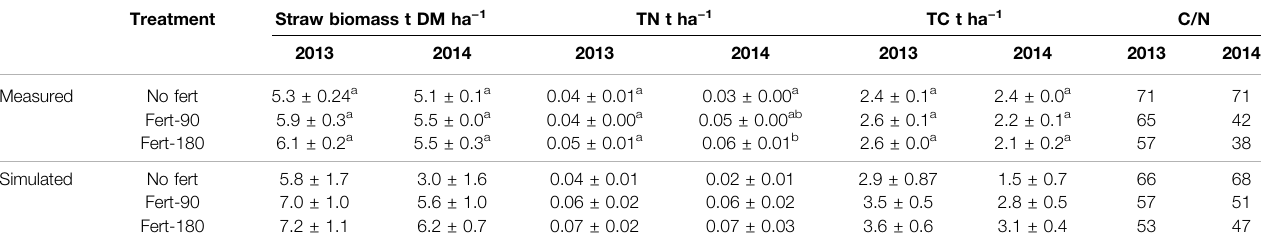
TABLE 1| Amountofincorporatedoilseedrapestrawbiomass,totalNandtotalCinstrawaswellasstrawC/NratioattheexperimentalsiteReinshofin2013and2014( n (cid:2) 3) as in fl uenced by fertilizer treatments. Different lowercase letters indicate signi fi cant differences among treatments at p < 0.05.